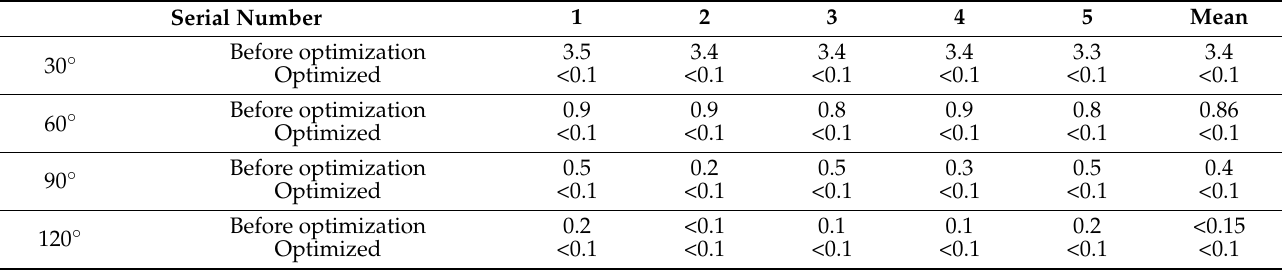
Table 3. Printing fit measurement data of CFRF